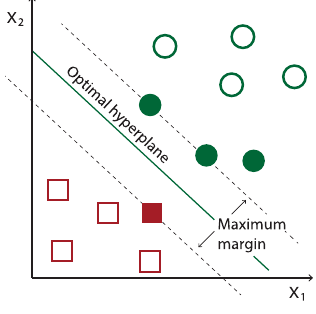
Figure 1. SVM geometric